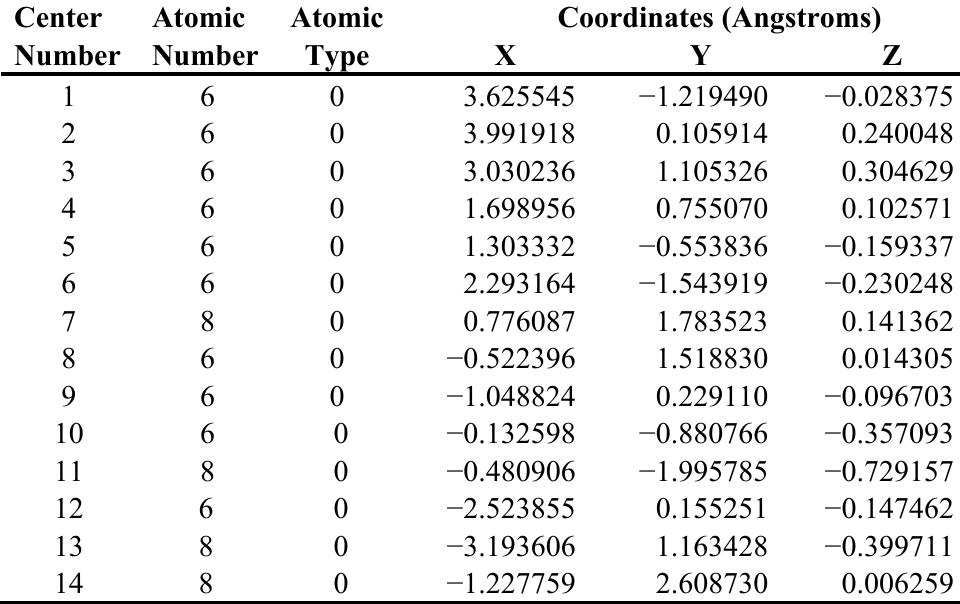
Table S3. XYZ coordinates for tautomer